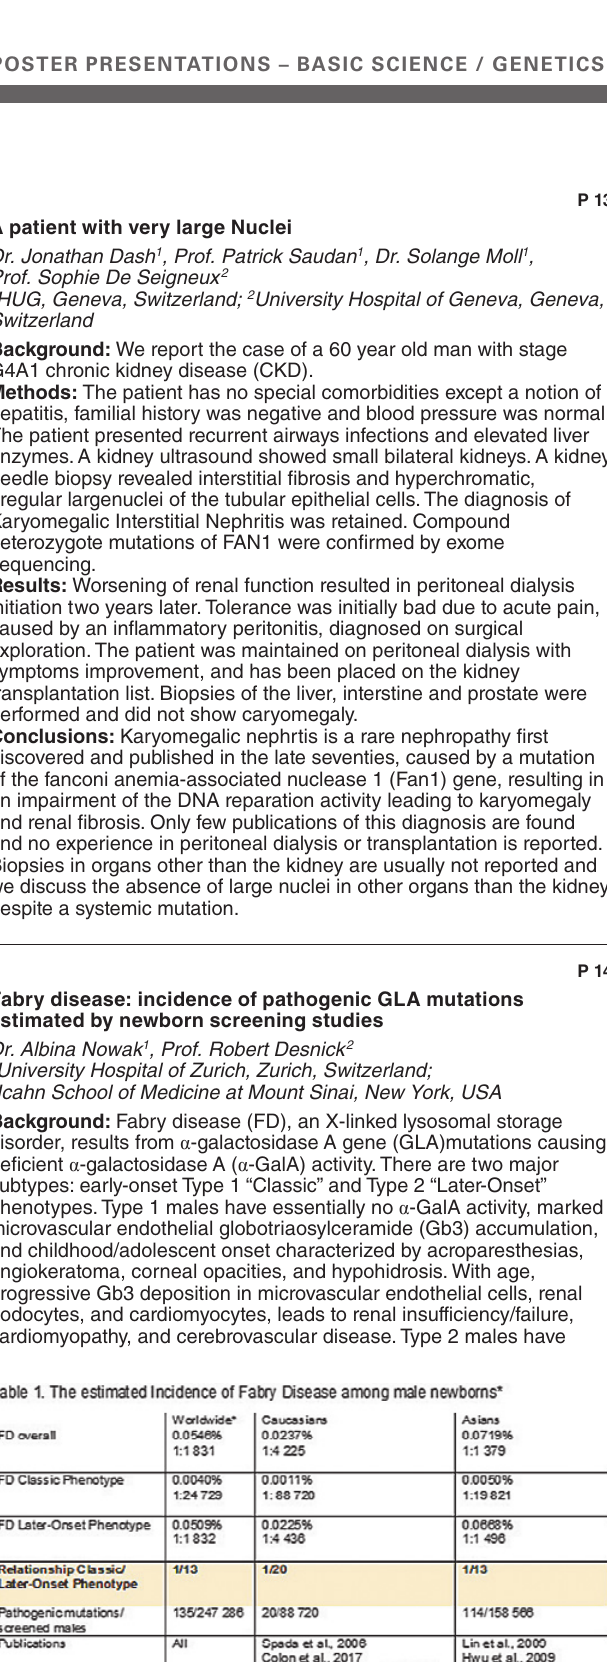
Figure 2: Number of male newborns with mutations.